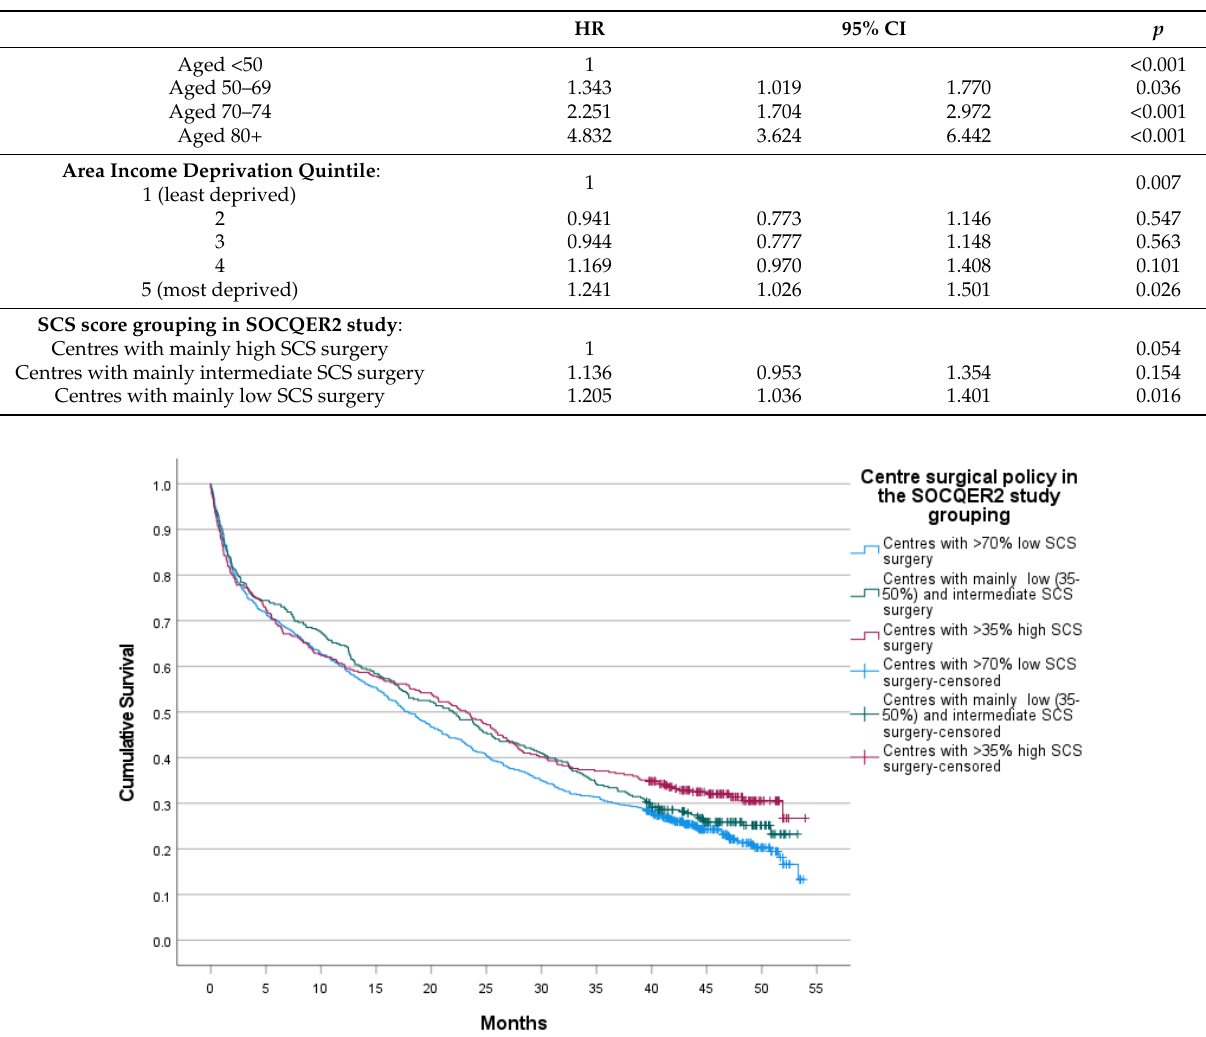
Table 4. Adjusted hazard ratios for Death.